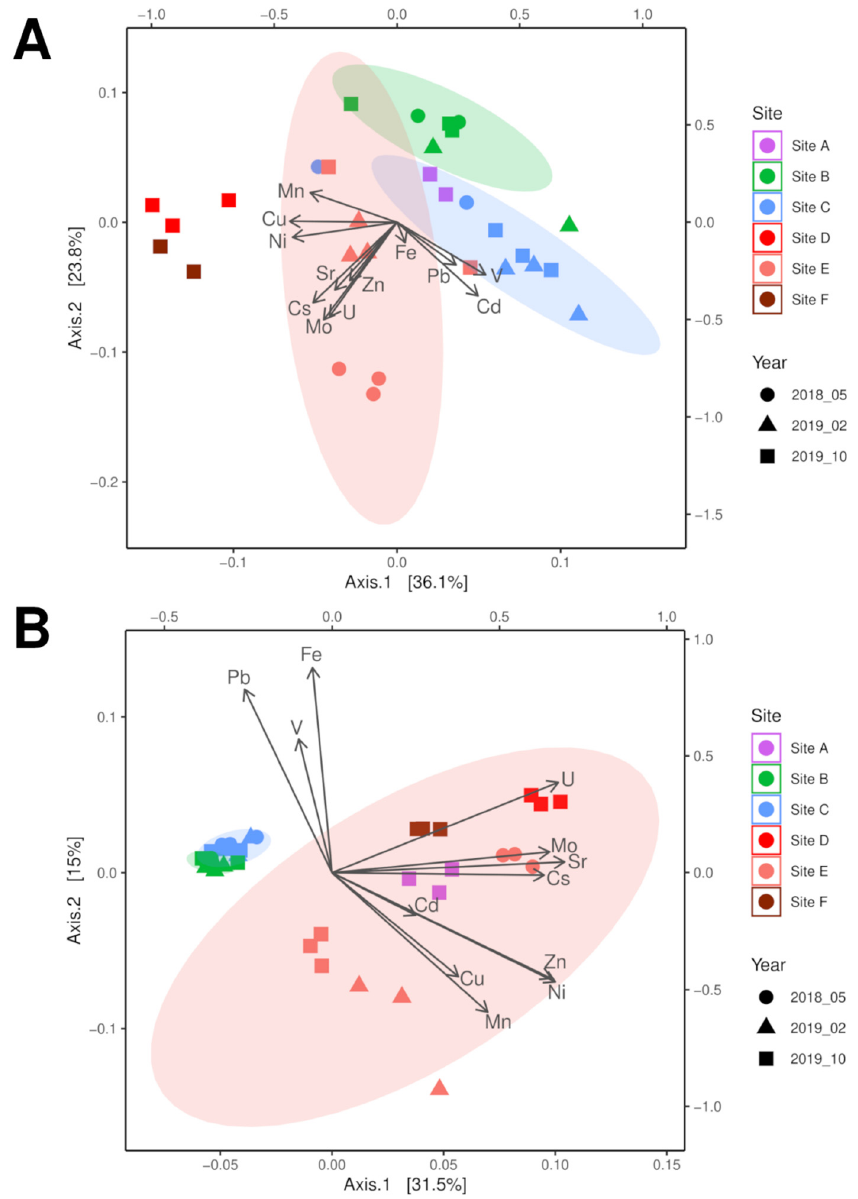
Figure 2. PCoA analysis of bacterial 16S ( A ) and fungal ITS ( B ) microbiome data correlated with physicochemical soil parameters in a contamination gradient from sampling site A through site F (compare Supplementary Table S1).